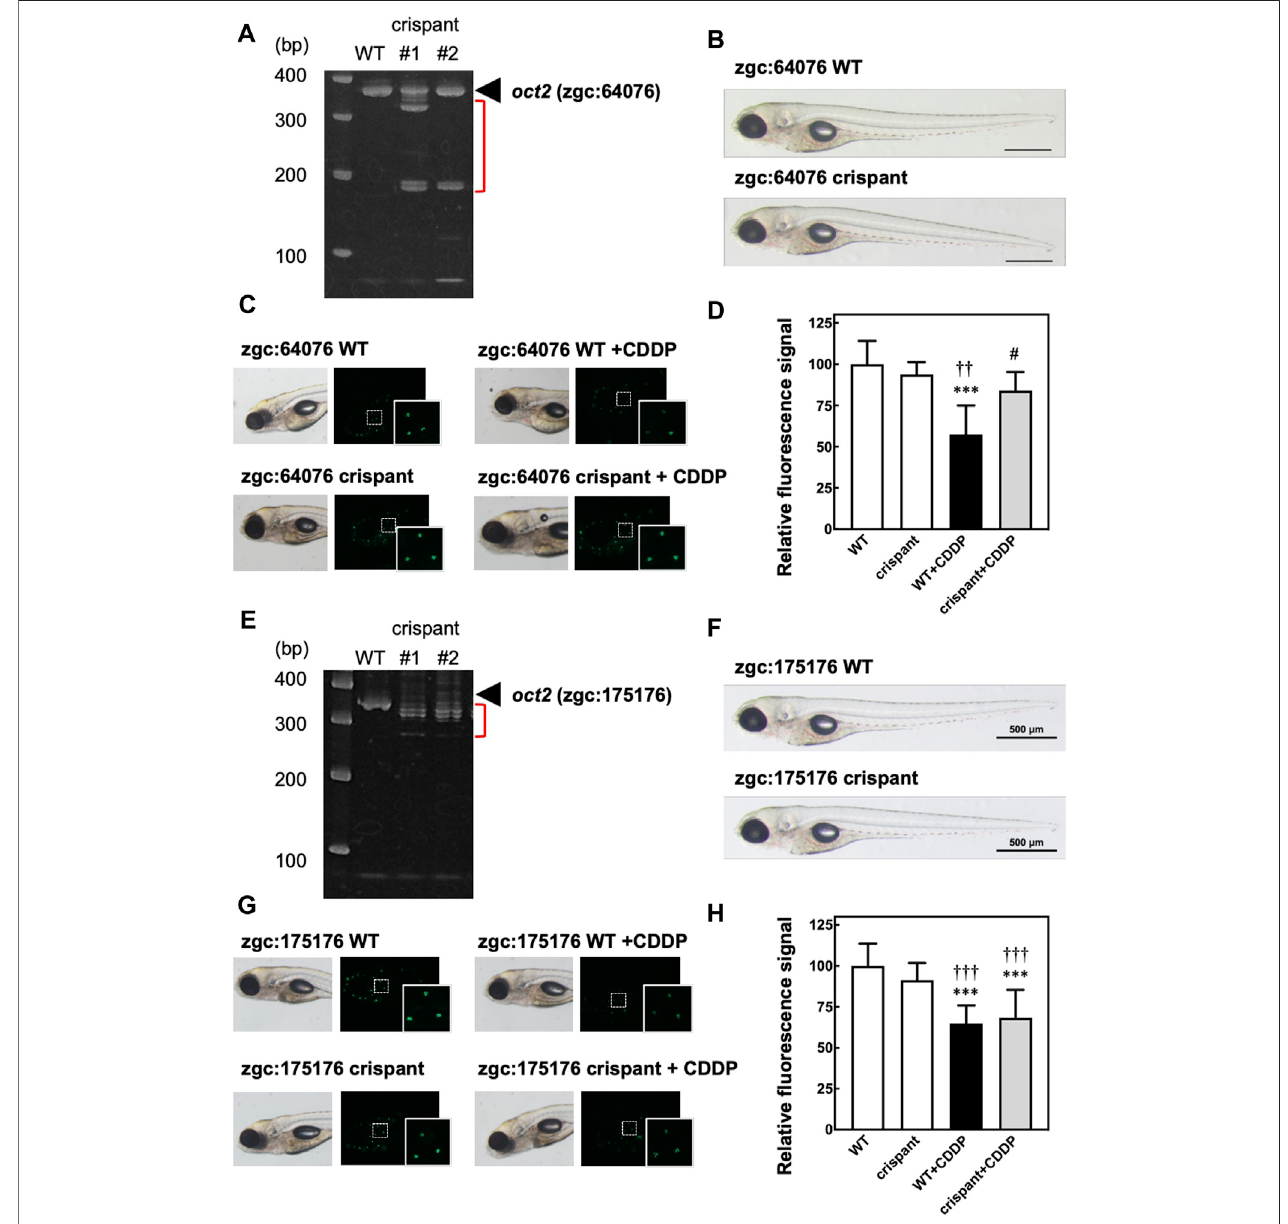
FIGURE 2 | In vivo fl uorescence imaging of hair cells in crispant zebra fi sh to assess the involvement of oct2 in the decrease of fl uorescence signals caused by CDDP. Crispant zebra fi sh with knockout (KO) of zgc:64,076 or zgc:175,176 , zebra fi sh homologs of OCT2, were generated using CRISPR-Cas9 technology. (A,E) Electrophoresis of genomic PCR around the sequences targeted by genome editing of zgc:64,076 (A) or zgc:175,176 (E) . (B,F) Bright fi eld imaging of both wild-type (WT)and crispant zebra fi sh forzgc:64,076 (B) and zgc:175,176 (F) .C,D, G,and (H) WT and crispant zebra fi shfor zgc:64,076 (C,D) and zgc:175,176 (G,H) were treated with or without CDDP, followed by staining with Yo-Pro-1 of sensory hair cells. The fl uorescence signals of three neuromasts including hair cells shown in the white rectangles were calculated and are shown as the percentage of the signal of WT zebra fi sh without CDDP treatment.